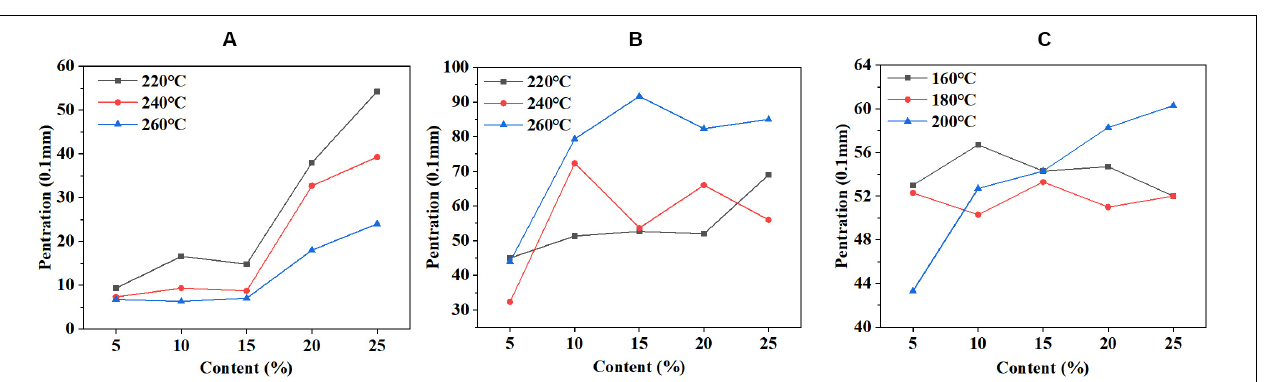
FIGURE 2 | Penetration test results of TB asphalt. (A) TB-A. (B) TB-B. (C)